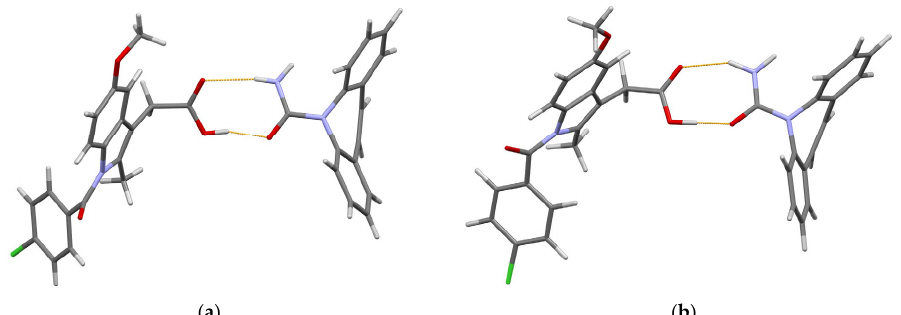
Figure 2. (Prepared with Mercury [65]). The hydrogen-bonded pair of carbamazepine and indometh- acin molecules in 1:1 cocrystal of ( a ) form I and ( b ) form II. Thin orange lines denote intermolecular N–H…O and O–H…O hydrogen bonds.